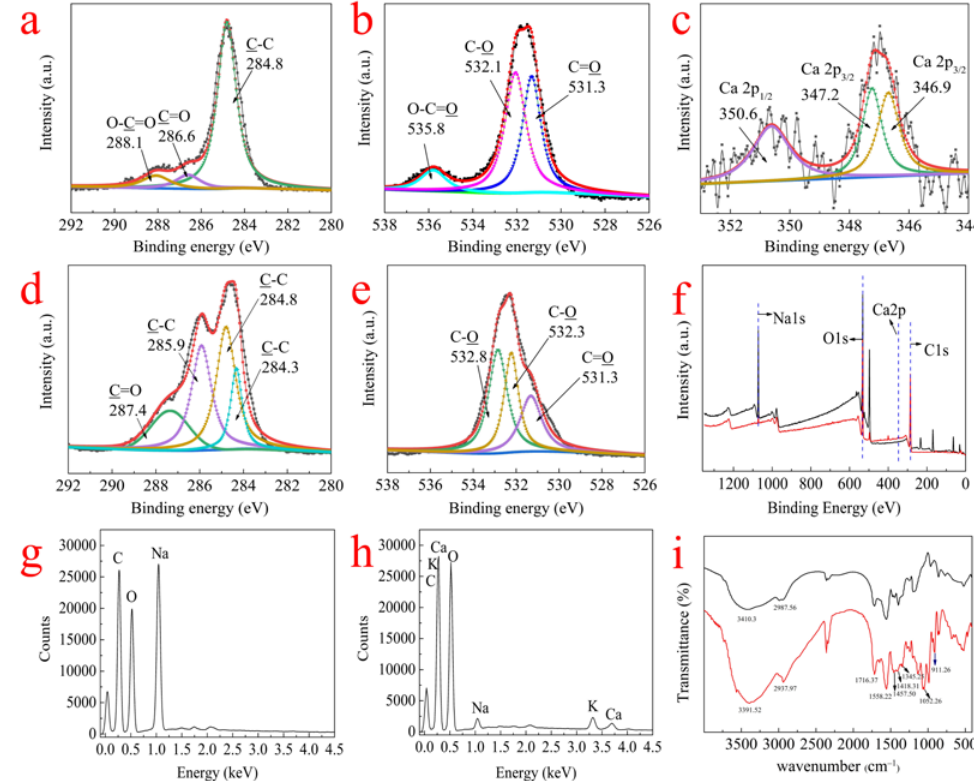
Figure 8. XPS C1s ( a , d ) and O1s ( b , e ) spectra of RMCRs and their deconvolution into component peaks before and after adsorption of calcium ions, respectively, and XPS spectra of calcium ions ( c ) for RMCRs with adsorbed calcium ions, XPS fully scanned spectra ( f ), EDS spectra of RMCRs ( g ) and RMCRs with adsorbed calcium ions ( h ), and FTIR spectra ( i ) of RMCRs (black solid line) and RMCRs with adsorbed calcium ions (red solid line).